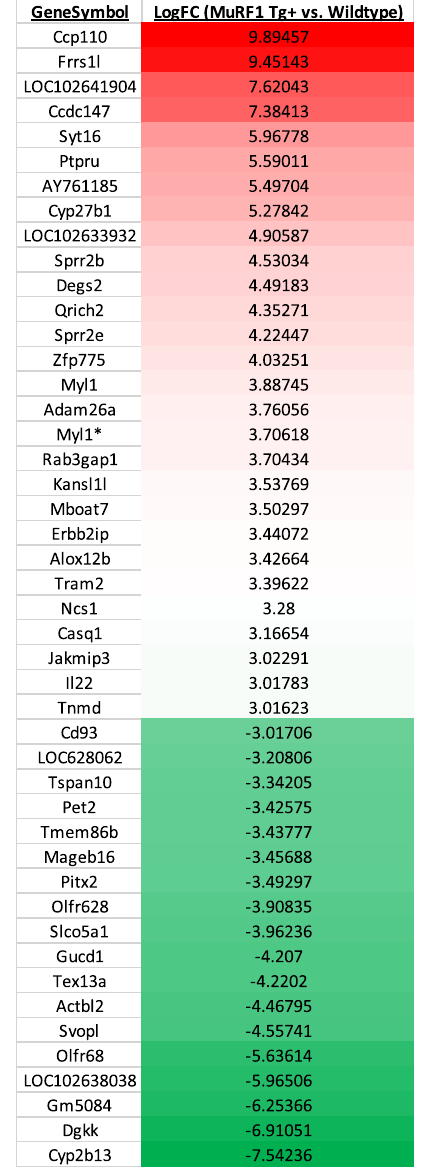
Fig. 3 Differential gene expression of MuRF1 Tg+right ventricle after three weeks CH exposure. a. Summary of how differentially expressed genes in hypoxia-challenged MuRF1Tg+right ventricles were identified. b. Top 27 increased unique genes (>3-fold) and top 18 decreased unique genes (< − 3-fold) compared to wild-type MuRF1Tg+ RV tissue. Asterisk (*) designates transcript variant for duplicate gene name. MuRF1 Tg+: N =3; strain-matched wild type: N